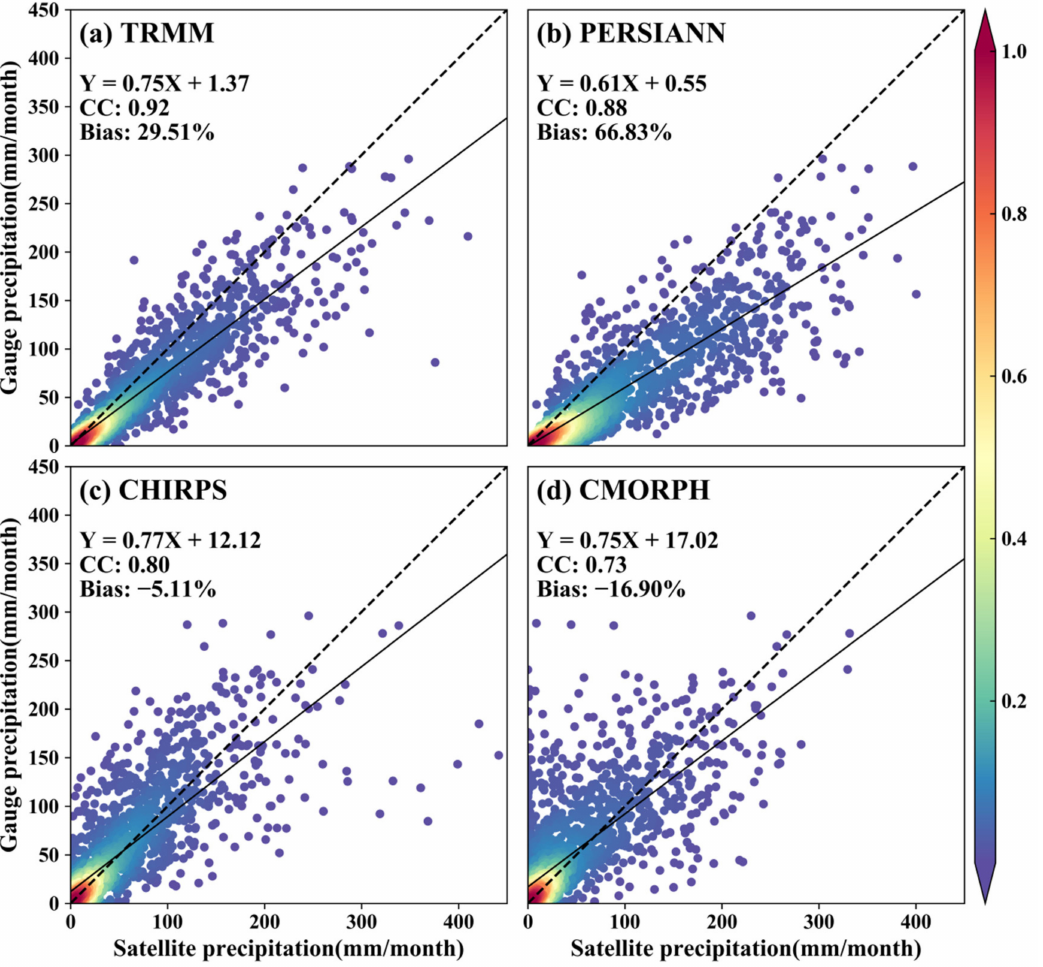
Figure 6. Scatter density of rain gauged precipitation at monthly scale and corresponding grids for four products from 2000 to 2008: ( a – d ) plots of TRMM, PERSIANN, CHIRPS, and COMRPH,